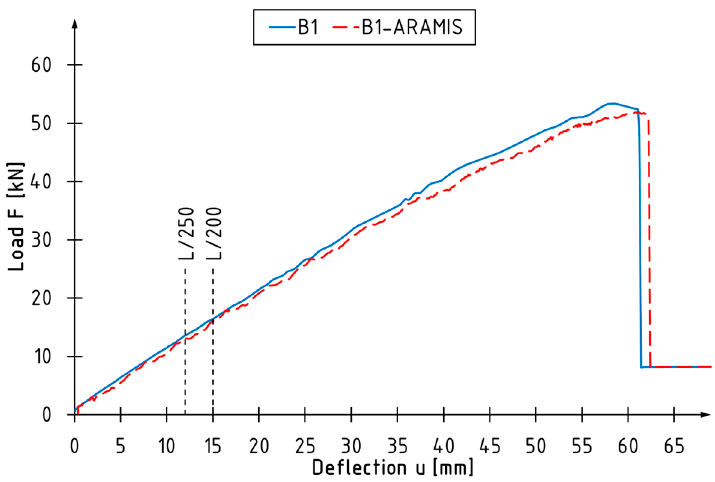
Figure 10. Comparison of midspan deflection measured using DIC and LVDT system in the function of